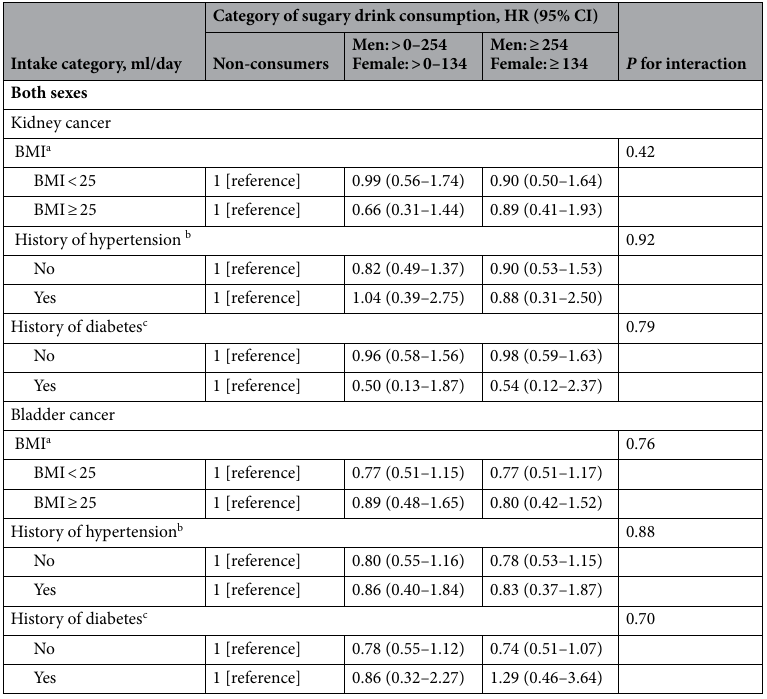
Table 3. Hazards for kidney and bladder cancer incidence according to intake of sugary drinks, stratified by body mass index, history of hypertension and diabetes. HR hazard ratio, CI confidence interval, No. number. Multivariable Cox regression model adjusted for age (year); public health center (10 areas); body mass index (< 18.5, 18.5 to < 25, 25 to < 30, or 30 to < 45); history of hypertension (yes or no); history of diabetes (yes or no), smoking status and intensity (never; former; current: < 20 cigarettes per day; current: ≥ 20 cigarettes per day); consumption of alcohol (ethanol gram per week), coffee (gram per day), fruit (g per day, tercile), vegetables (g per day, tercile), biscuits (g per day, tercile), cake (g per day, tercile), chocolate (g per day, tercile), and Japanese-style confectionery (g per day, tercile); physical activities (metabolic equivalent task, hours per day, tercile); height (cm, tercile); and intake of total energy (kcal per day) (all continuous). a Body mass index was not adjusted. b History of hypertension was not adjusted. c History of diabetes was not adjusted. Sugary drinks included beta-carotene-fortified beverages, calcium-fortified beverages, canned coffee, carbonated beverages, 100% fruit juices (apple juice and orange juice), lactic acid bacteria beverages, and vitamin-fortified